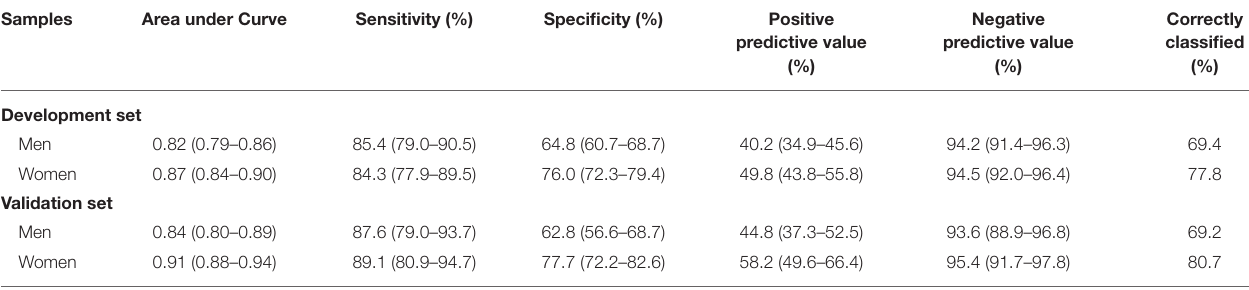
TABLE 3 | Performance of the SarSA-Mod in the development and validation samples. Samples Area under Curve Sensitivity (%) Specificity (%) Positive